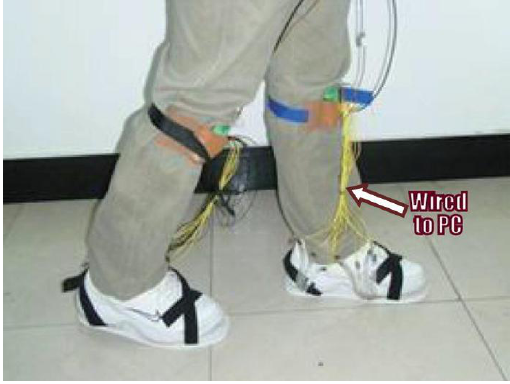
Figure 16. Identification based on dynamic plantar pressure in-shoe system [5].